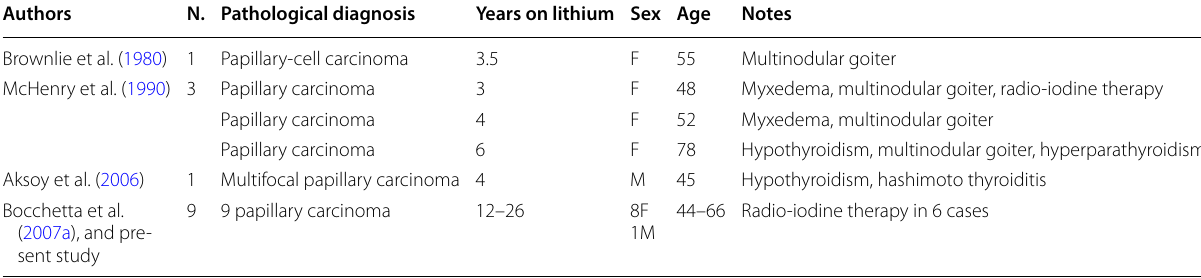
Table 4 Characteristics of thyroid tumors from the literature and from the present case series